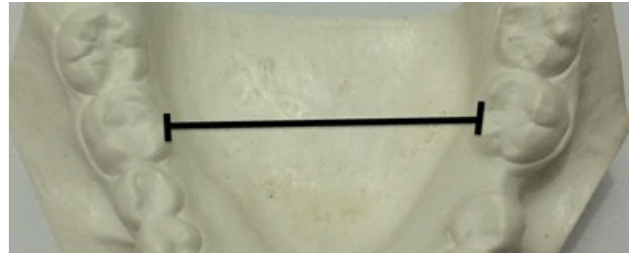
Fig.3. Distance between the lingual cusps of the molars in opposite quadrants. Source: current